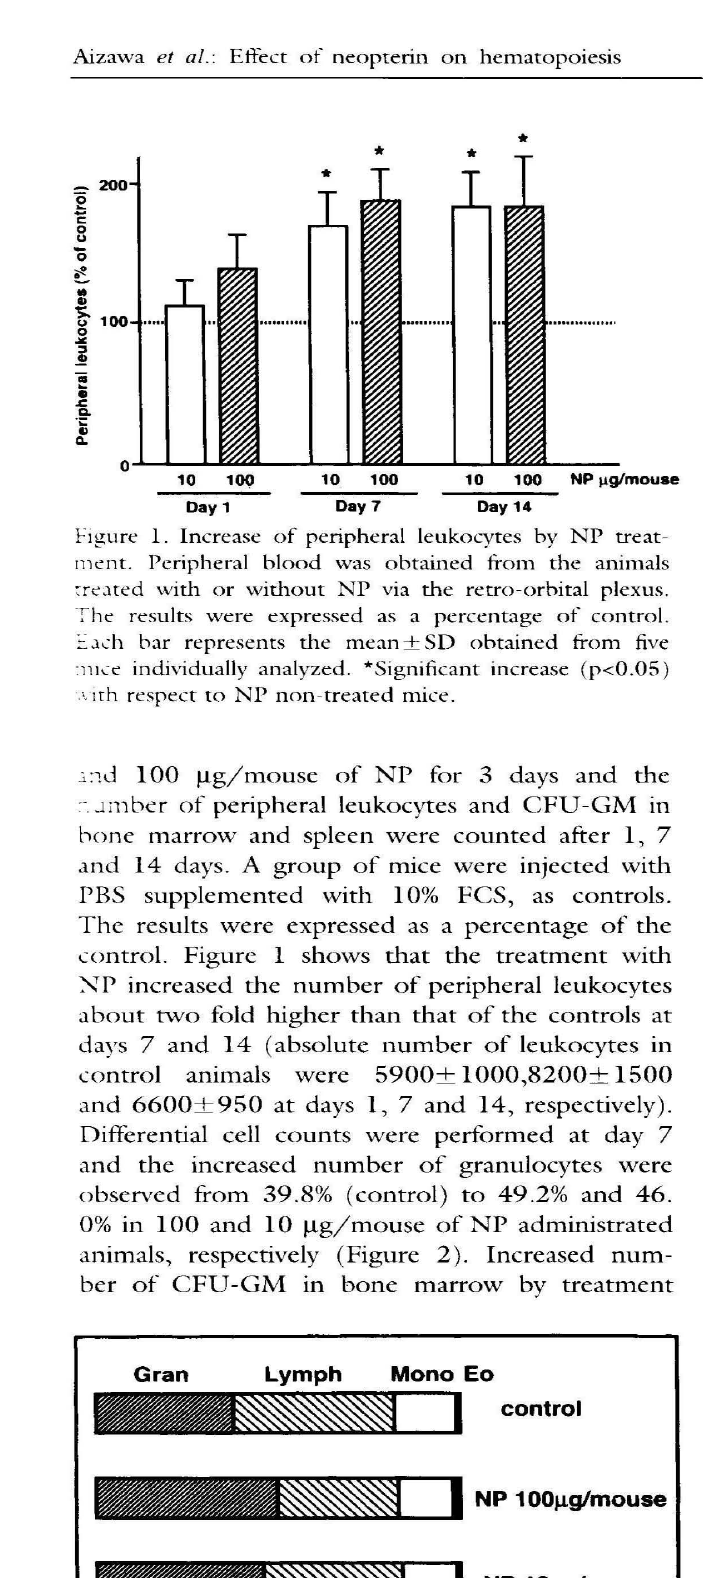
14361±260I, 15050± 1194 and 14345± 1367 at days 1, 7 and 14,